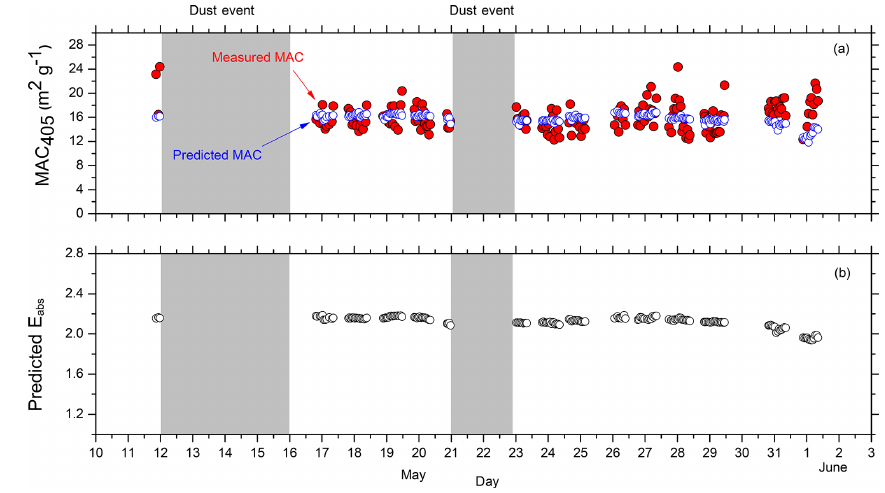
Figure 6. Hourly averaged results from the Mie theory calculations, assuming a nonabsorbing shell ( k = 0). (a) Predicted (blue circles) and measured MAC 405 (red circles). (b) Hourly averaged predicted E abs values. The shading represents the dust event periods.